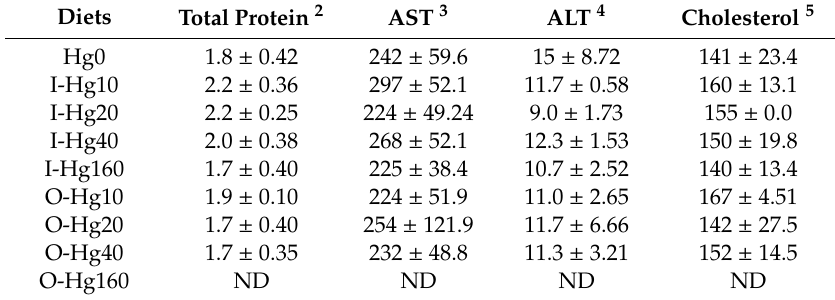
Table 5. Blood biochemical characteristics of juvenile olive flounder, Paralichthys olivaceus, fed nine experimental diets for eight weeks 1